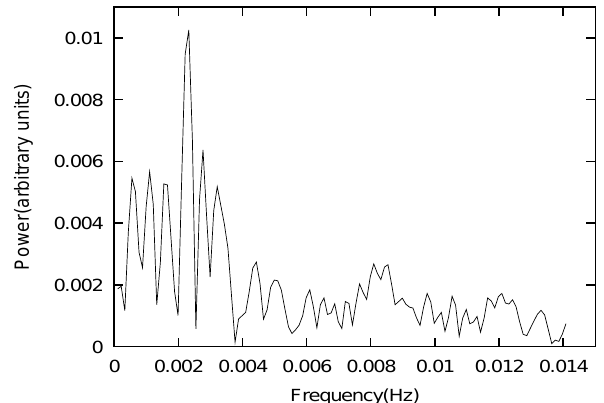
Fig. 1. Typical vertical velocity spectrum at an altitude of 5.1km during 20:55 to 21:56 LT on 24 August 1998.